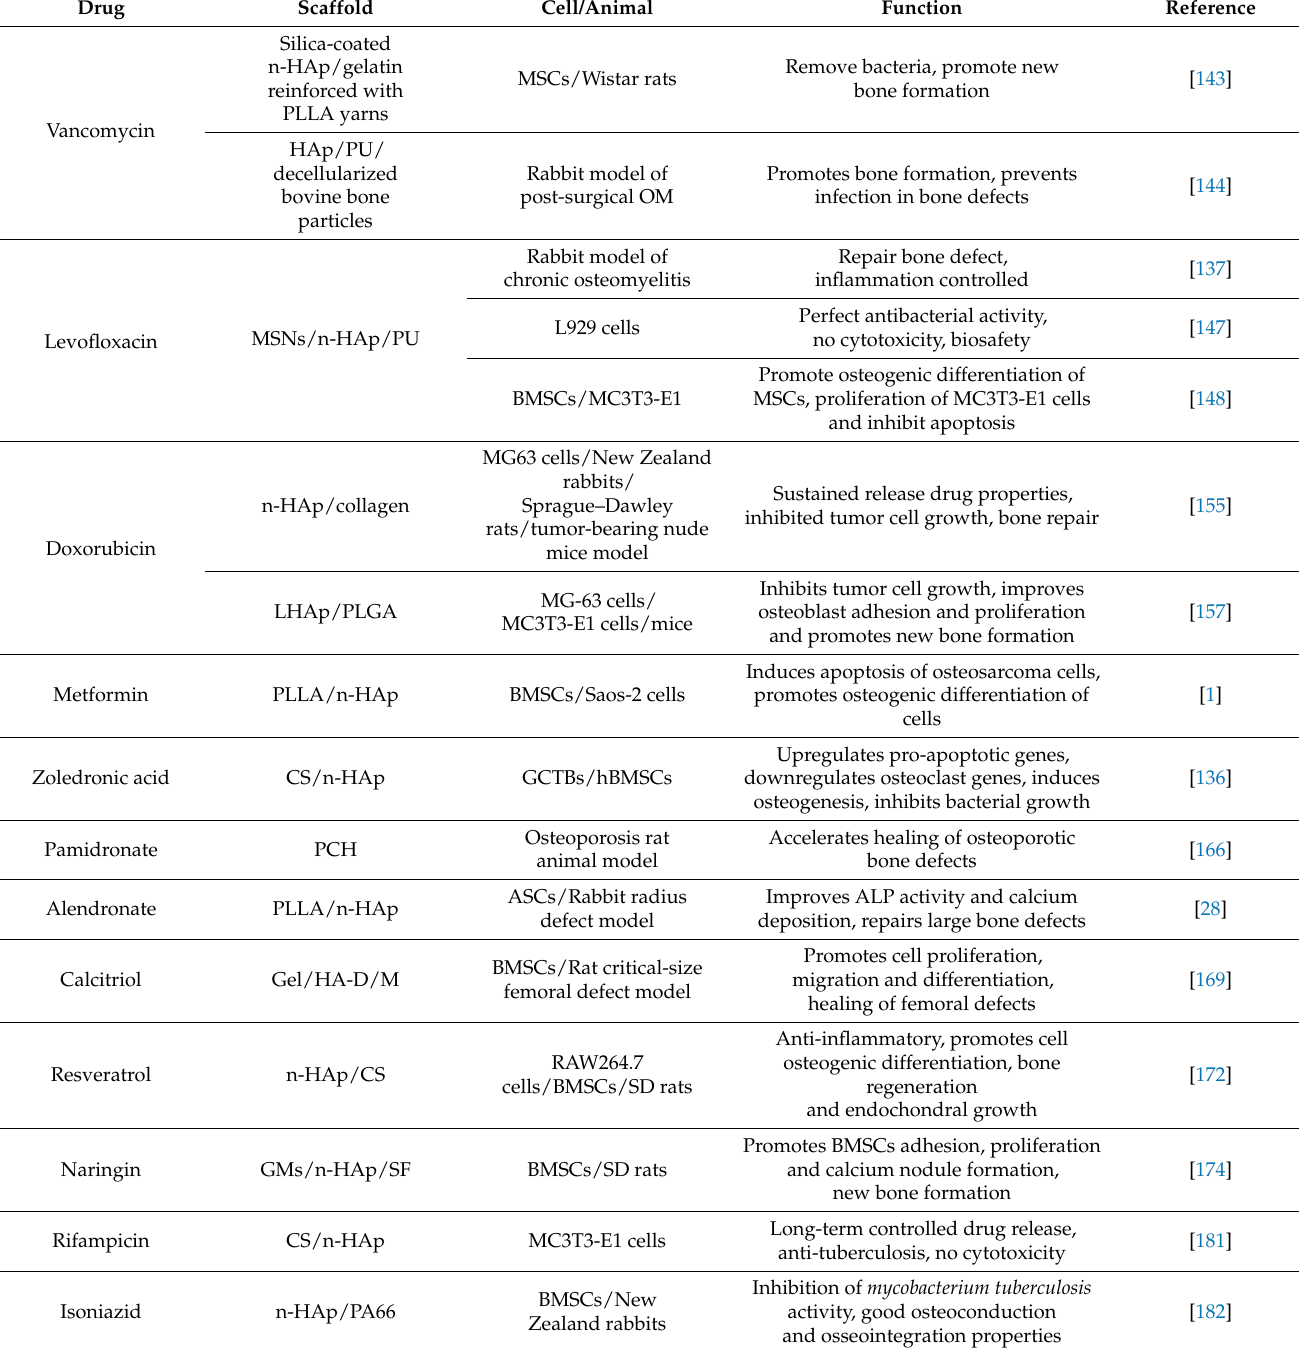
Table 5. Summary of n-HAp composites as drug carriers to promote bone